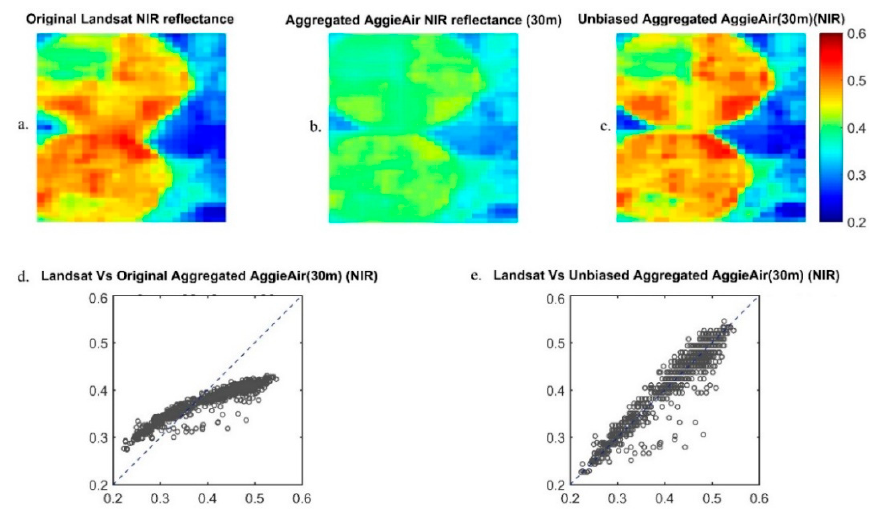
Figure 3. ( a ) Original Landsat NIR reflectance image; ( b ) aggregated AggieAir NIR image (resolution: 30 m); ( c ) Unbiased aggregated AggieAir NIR image (resolution: 30 m); ( d ) Scatterplot of Landsat versus the original aggregated AggieAir NIR image; ( e ) Scatter lot of Landsat versus the unbiased aggregated AggieAir NIR image.